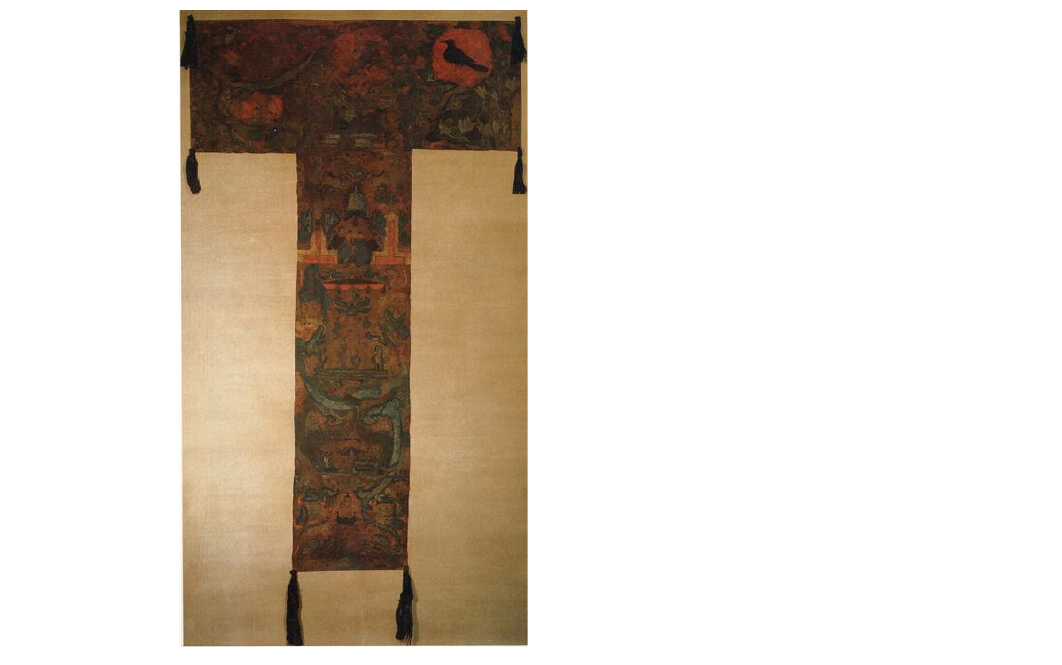
Figure 3. T-shaped silk painting from Tomb 3 in Mawangdui, Western Han dynasty. Tomb 3 also yielded silk manuscripts found in another lacquer box on the east wall.